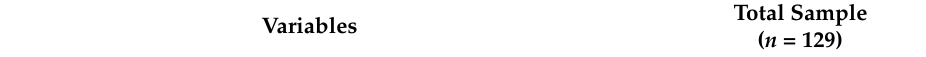
Table 1. Characteristics of the